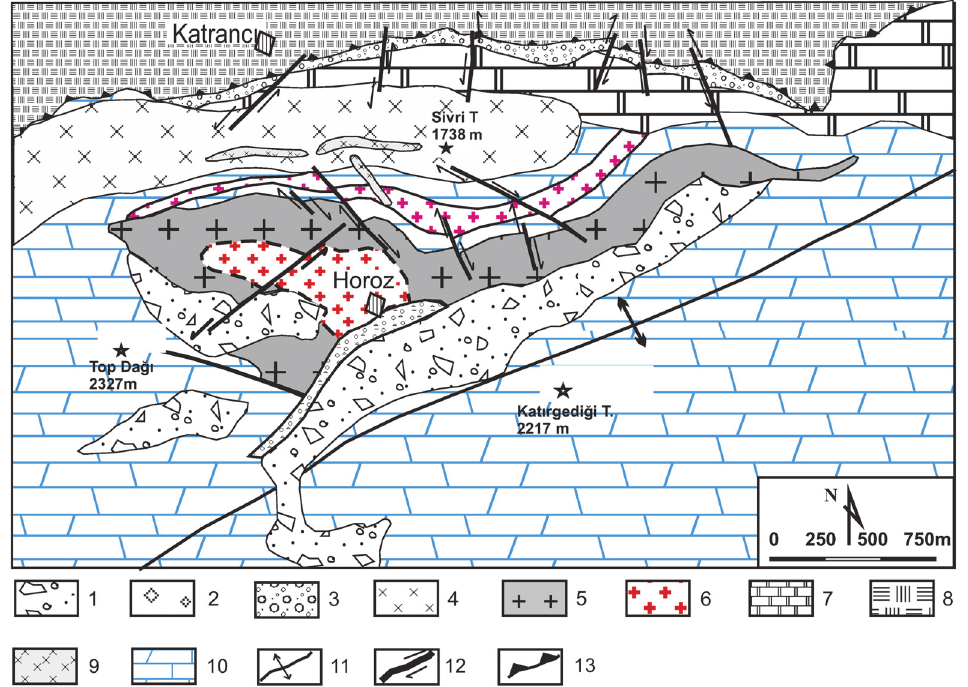
Fig. 2. Geological map of the Horoz area (modified from Çevikba ş et al. 1995 and Kadioglu & Dilek 2010). 1, Talus (Quaternary); 2, terrace (Plio-Quaternary); 3, Geyikp ı nar ı conglomerate member (Palaeocene); 4, Yatakta ş quartz-porphyry (U. Cretaceous–Palaeocene); 5, granite (Eocene); 6, granodiorite (Eocene); 7, Kalkankaya formation (U. Maestrichtian–L. Palaeocene); 8, Alihoca ophiolitic complex (Cretaceous); 9, Madenköy ophiolitic mélange (Cretaceous); 10, Bolkarda ğ ı marble (Permian); 11, anticline; 12, wrench fault; 13, thrust